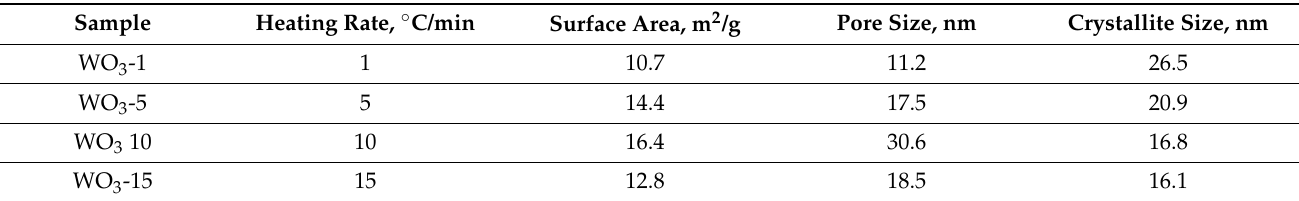
Table 2. Parameters of electrospun WO 3 nanofibers, used for fabrication of NO 2 gas sensors.